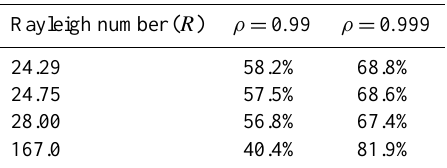
Table 1. The proportion of wavelet coefficients fixed in place as a function of R for our two choices of ρ